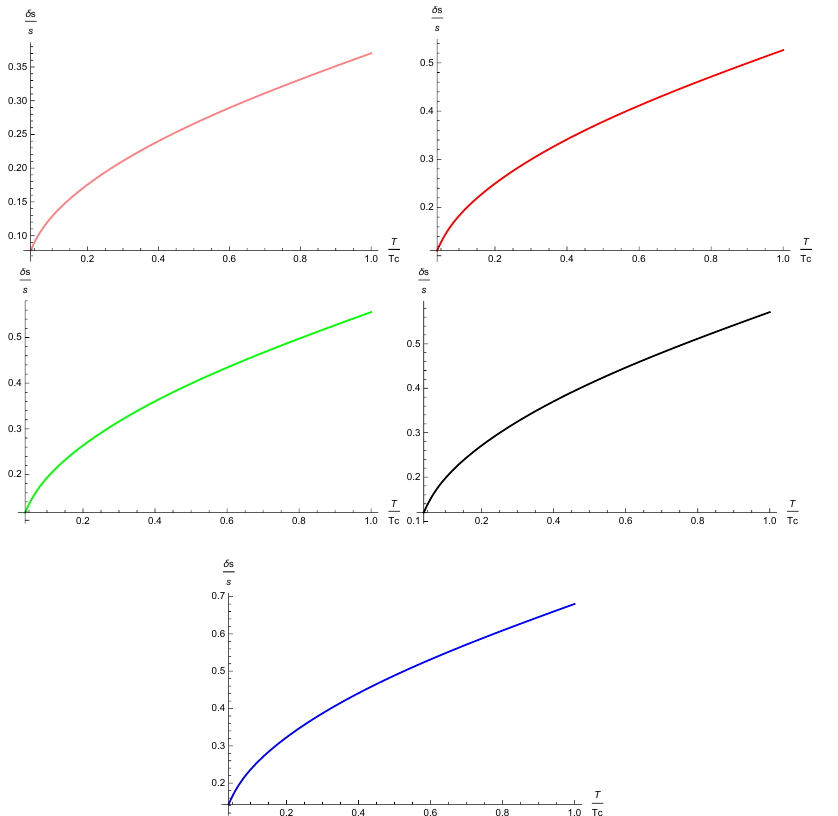
Figure 1. The figures show the entropy production for five different benchmark (BM) points: Pink line (BM 23, T c = 135.38 GeV and δ s / s = 37%), Red line (BM 10, T c = 153.27 GeV and δ s / s = 53%), Green line (BM 1, T c = 161.36 GeV and δ s / s = 30%), Black line (BM 15, T c = 168.61 GeV and δ s / s = 59%), and Blue line (BM 20 T c = 230.18 GeV and δ s / s =